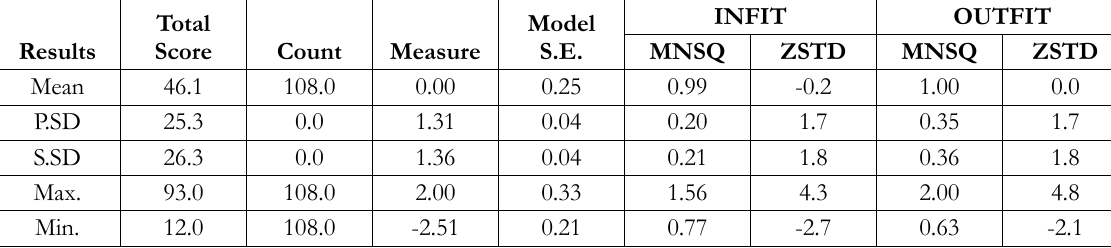
Table 4. Summary of measured